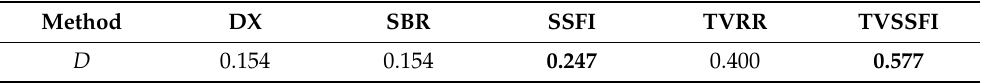
Table 10. List of diagnostic accuracy indicators for the tested